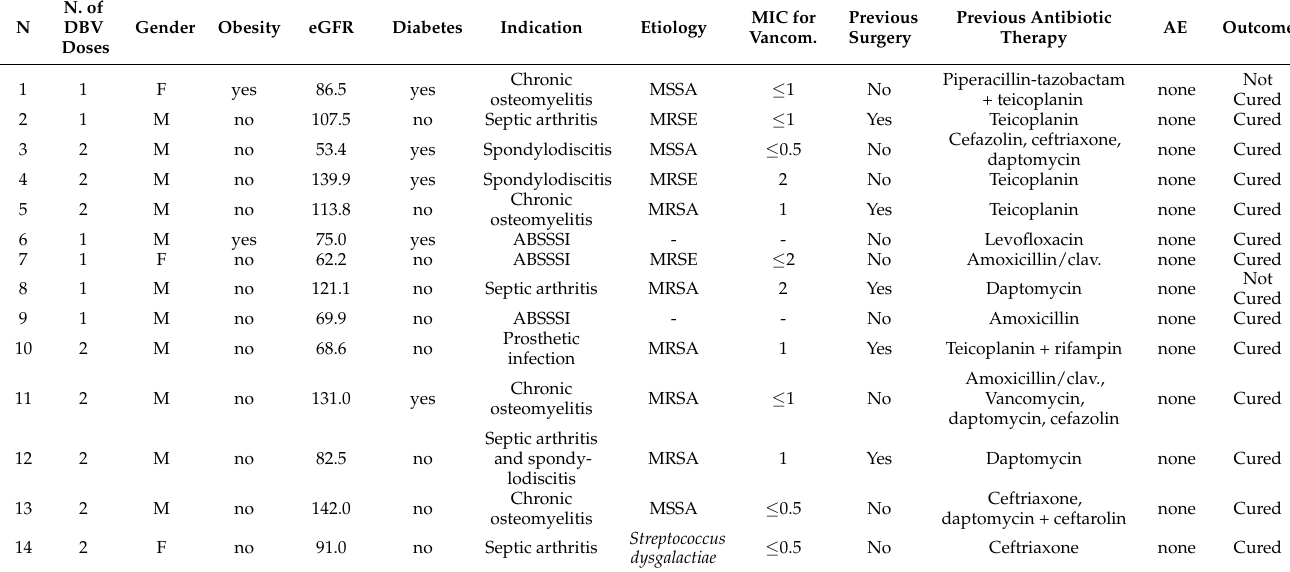
Table 1. Clinical features of the enrolled patients. Vancomycin MIC ≤ 2 was considered as a categorical surrogate of susceptibility to DBV. MSSA: methicillin-susceptible Staphylococcus aureus ; MRSA: methicillin-resistant Staphylococcus aureus ; MRSE: methicillin-resistant Staphylococcus epidermidis . N. of N